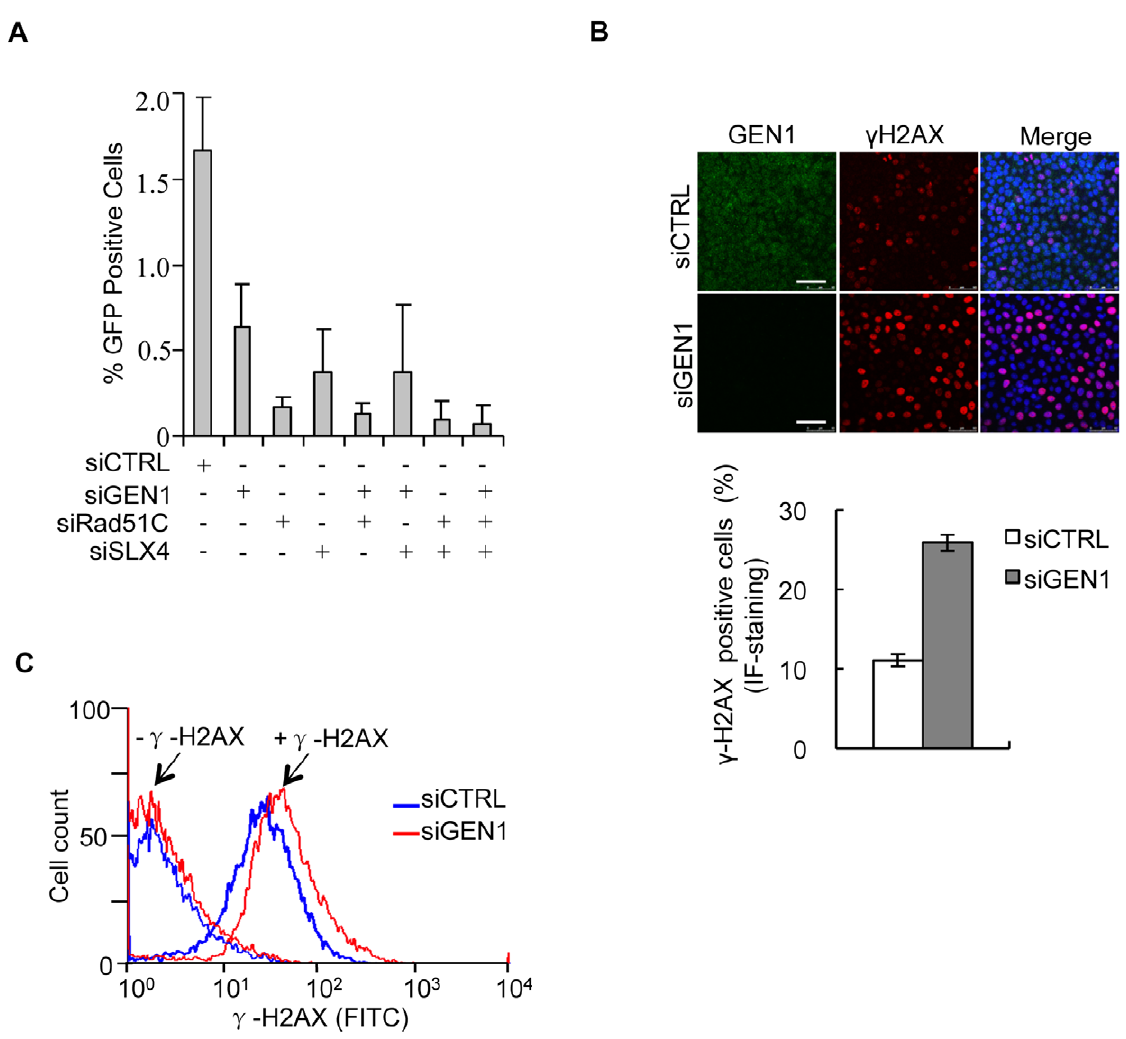
Figure 5. GEN1 is required for HR of DNA DSBs. A. 48 h following siRNA treatment with the indicated siRNAs U20S/DR-GFP cells were transfected with I-SceI plasmid for 48 h. Cells were processed for flow cytometric analysis of GFP, and the extent of HR was scored as the number of GFP-positive cells. Graph represents the mean of three independent experiments. Error bars indicate S.E.M. B. HeLa cells treated with CTRL or GEN1 siRNA (48 h) were fixed in ice-cold acetone–methanol (1:1) and immunostained with GEN1 and c -H2AX. Scale bar, 100 m m. Graph represents the mean of three independent experiments. (n=100 cells/condition/experiment). Error bars indicate S.E.M. C. HeLa cells were treated with CTRL or GEN1 siRNA for 48 h. After fixation in ice-cold acetone–methanol (1:1), half the cells were immunostained with c -H2AX and afterwards all cells were incubated with secondary antibody. The samples were then analyzed by flow cytometry and WinMDI software.